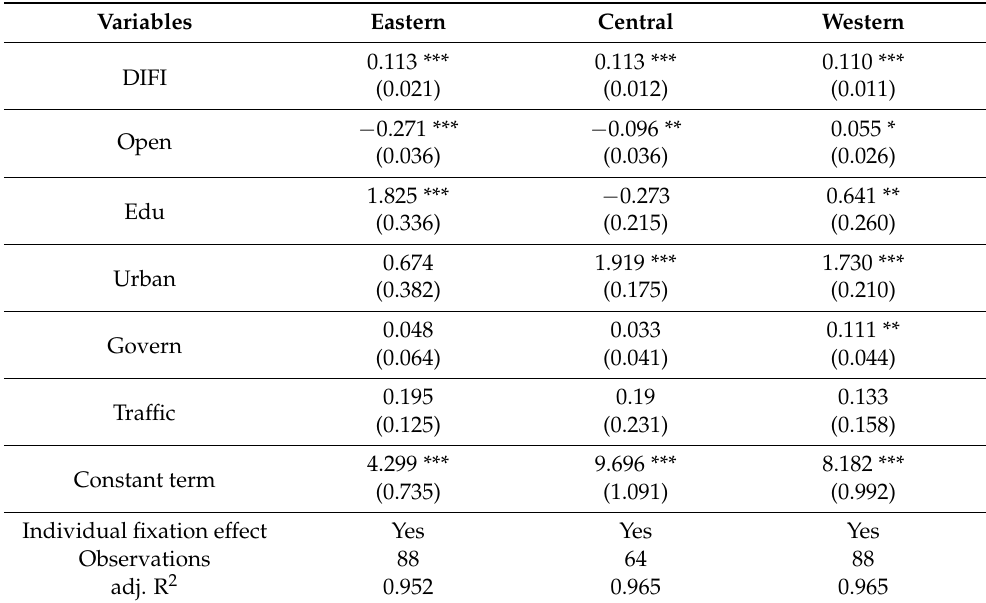
Table 4. DIFI’s regression results on per capita disposable income of rural households in eastern, central, and western China. Variables Eastern Central